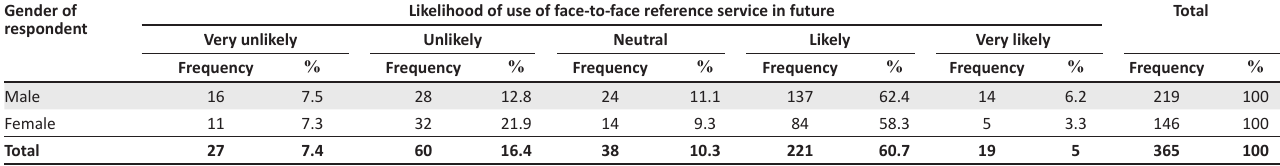
Likelihood of use of face-to-face reference service in future